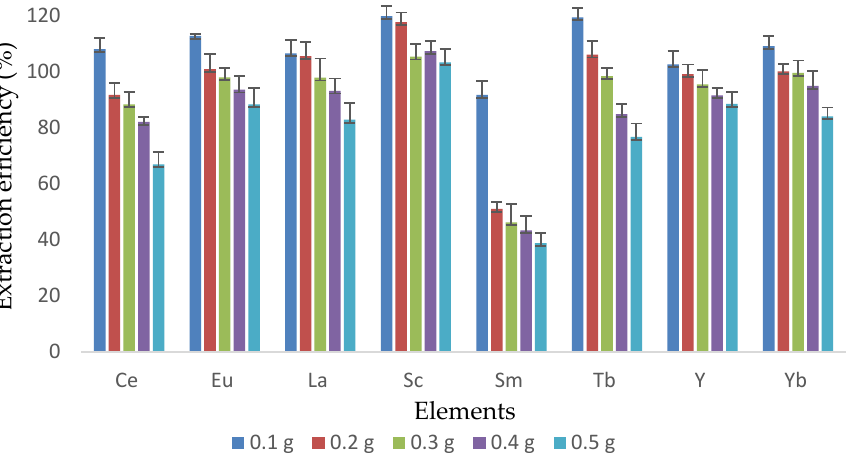
Figure 2. Effects of different masses (0.1–0.5 g) for the extraction of REEs in coal samples. UAE conditions: [HNO 3 ] (1 mol L − 1 ), sample mass (optimized), extraction time (30 min), UAE temperature (80 °C), UAE frequency (high), and replicates ( n = 3).